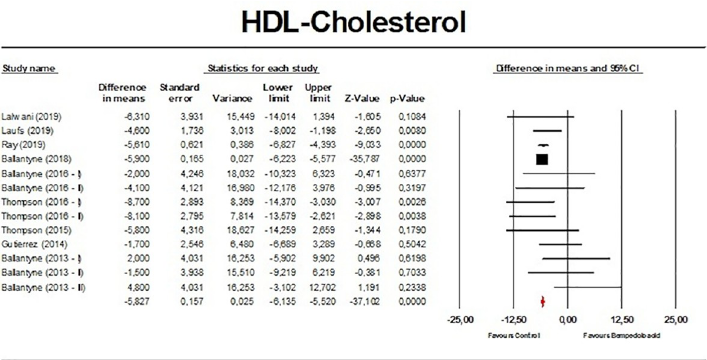
Fig 7. Forest plot displaying mean difference and 95% confidence intervals for the effect of bempedoic acid on plasma levels of high-density lipoprotein (HDL) cholesterol.